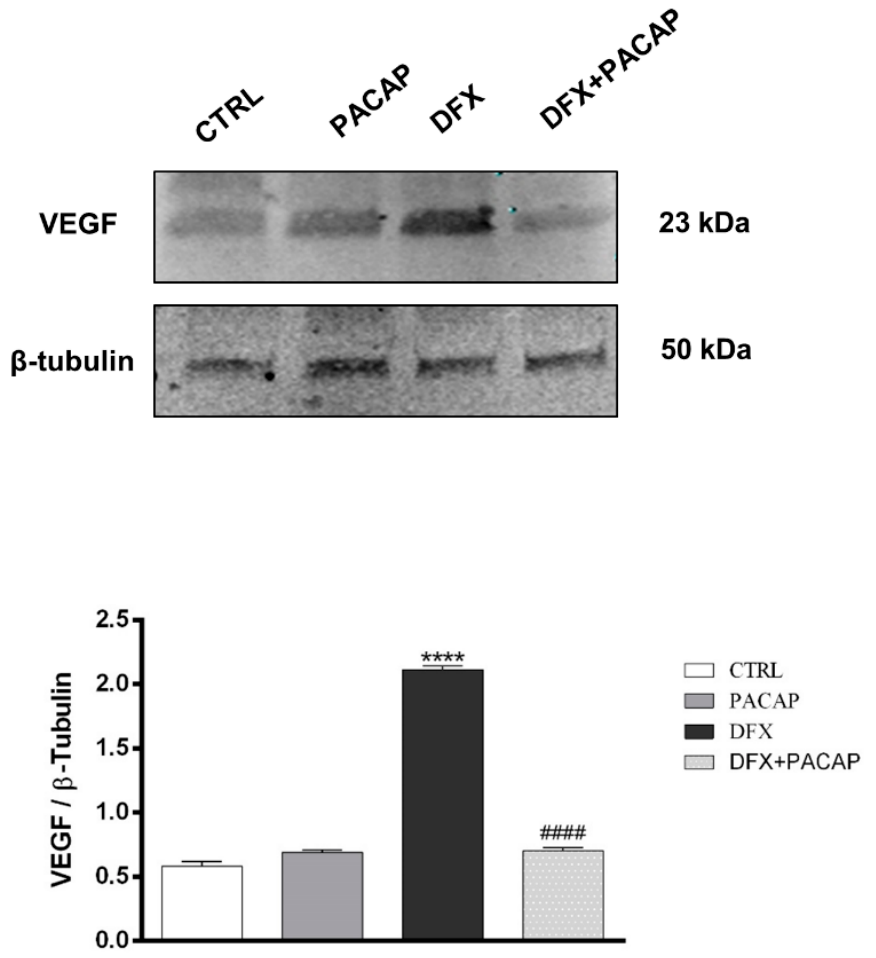
Figure 3. PACAP effect on VEGF expression in human GBM cells exposed to DFX-induced hypoxia. The expression of VEGF was evaluated in U87MG cells treated with vehicle or 100 nM of PACAP or DFX or DFX plus PACAP for 24 h through Western blot analysis. The bar graphs show quantitative analysis of signals obtained by immunoblots resulting from three independent experiments. Relative band densities were quantified by using ImageJ software. Protein levels are expressed as arbitrary units obtained following normalization to β -tubulin, which was used as loading control. Table 1. VEGF content in conditioned medium from U87MG cells. VEGF levels were detected in supernatants and expressed in pg/mL. Data resulting from three independent experiments are represented as means ± SEM. **** p < 0.0001 vs. CTRL; ### p < 0.001 vs.